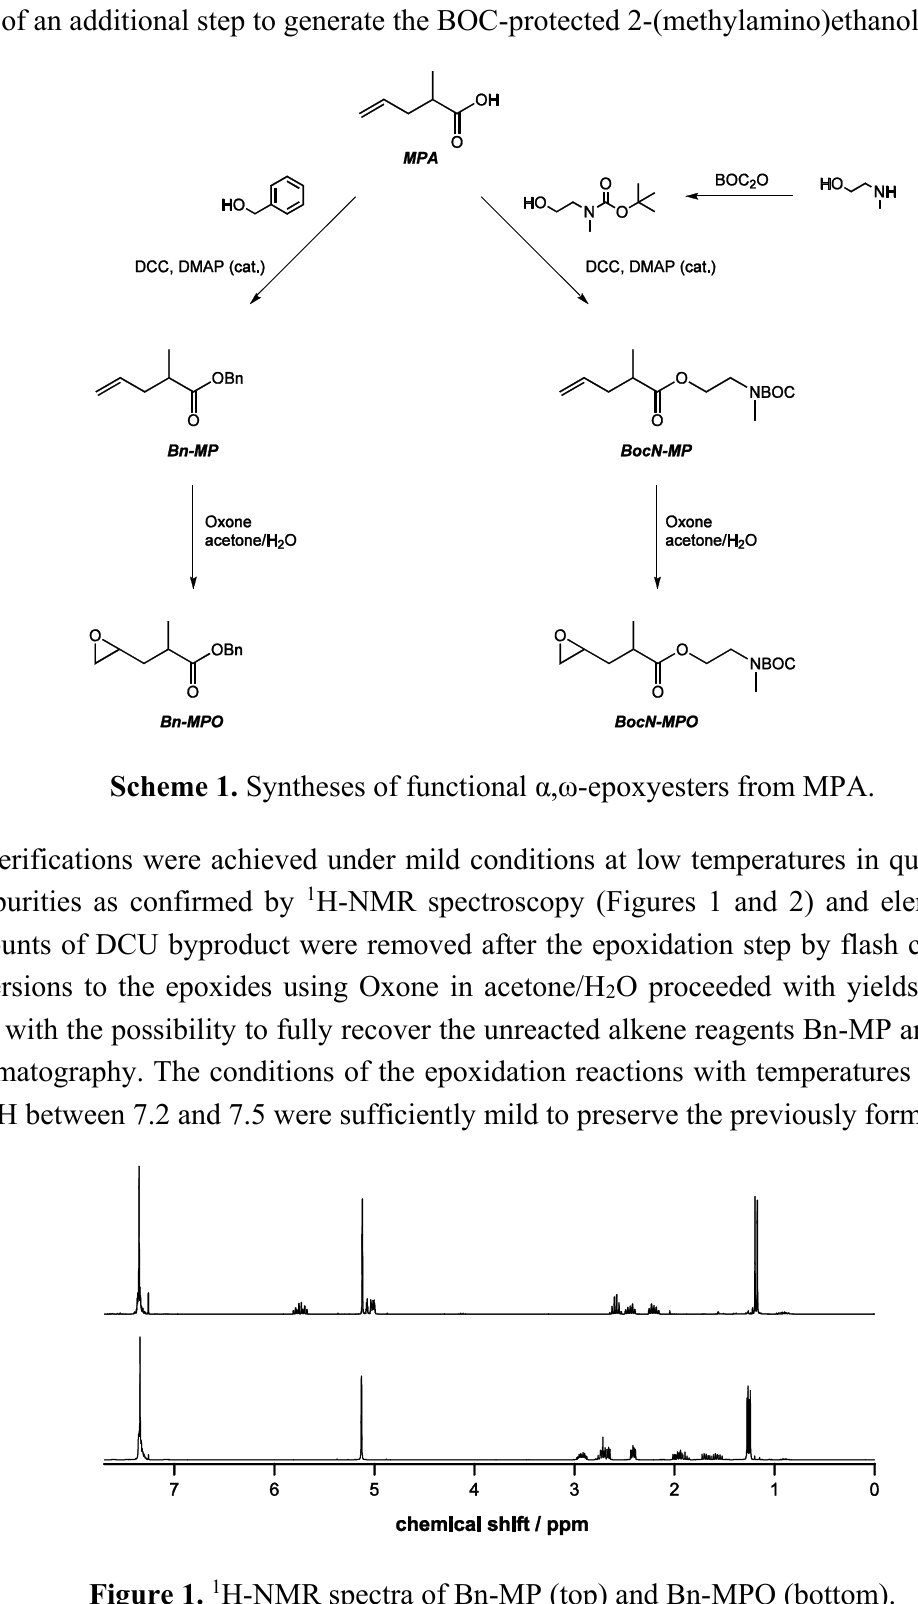
Figure 1. 1 H-NMR spectra of Bn-MP (top) and Bn-MPO